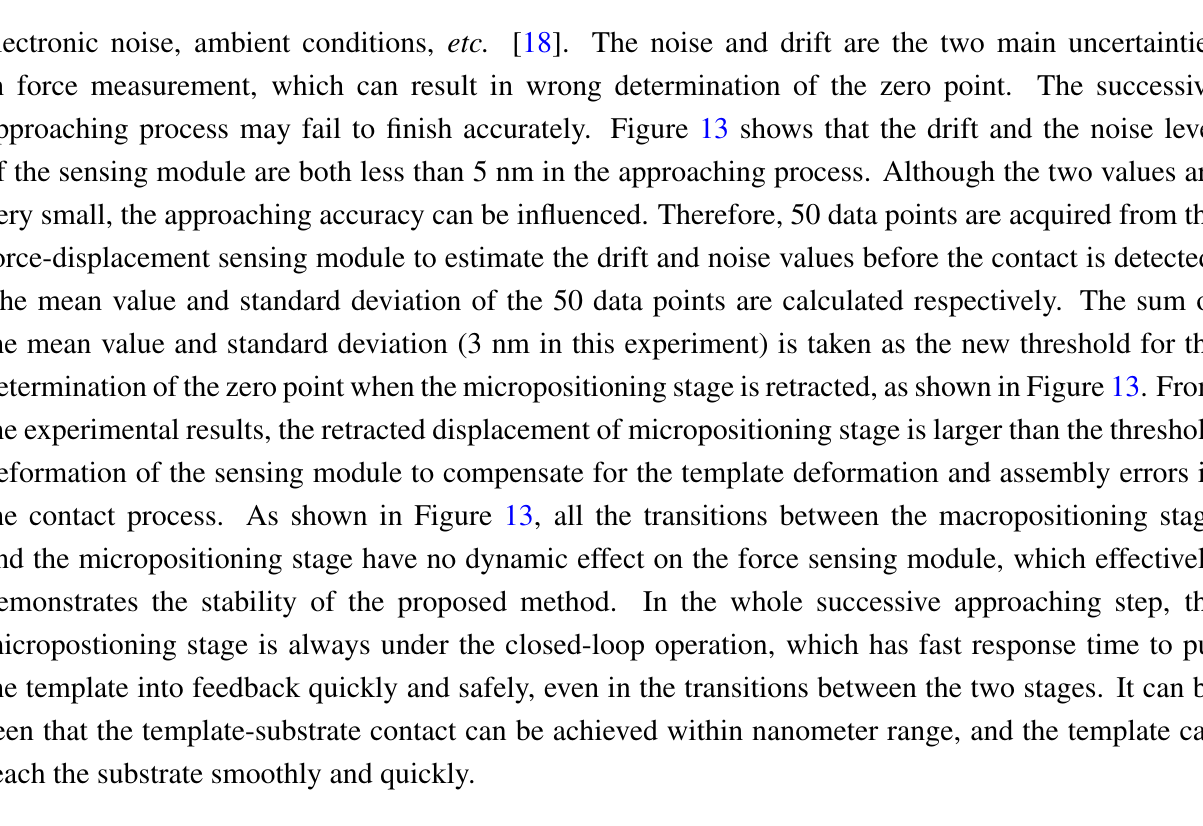
Figure 13. The experimental results of the approaching